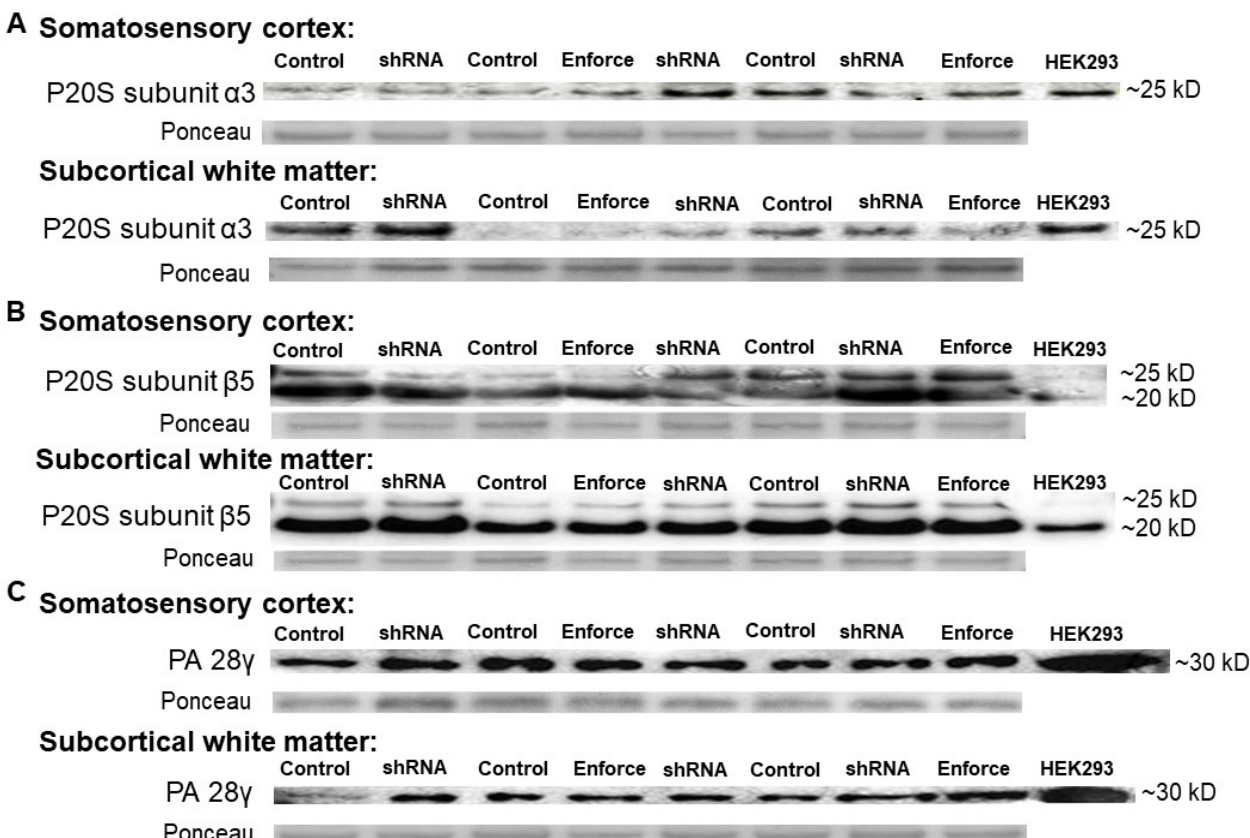
Figure 8. Western blotting for the proteasome 20S (P20S) subunits α 3 ( A ), β 5 ( B ), and PA28 γ ( C ) in the piglet somatosensory cortex and subcortical white matter after intracerebral injections of adeno-associated virus (AAV). The different injections were AAV-green fluorescent protein (GFP, control), AAV with shRNA to PA28 γ -GFP, or AAV-PA28 γ -GFP (enforce). A non-transfected HEK293 cell lysate provided an additional control. Ponceau S-stained membranes show protein